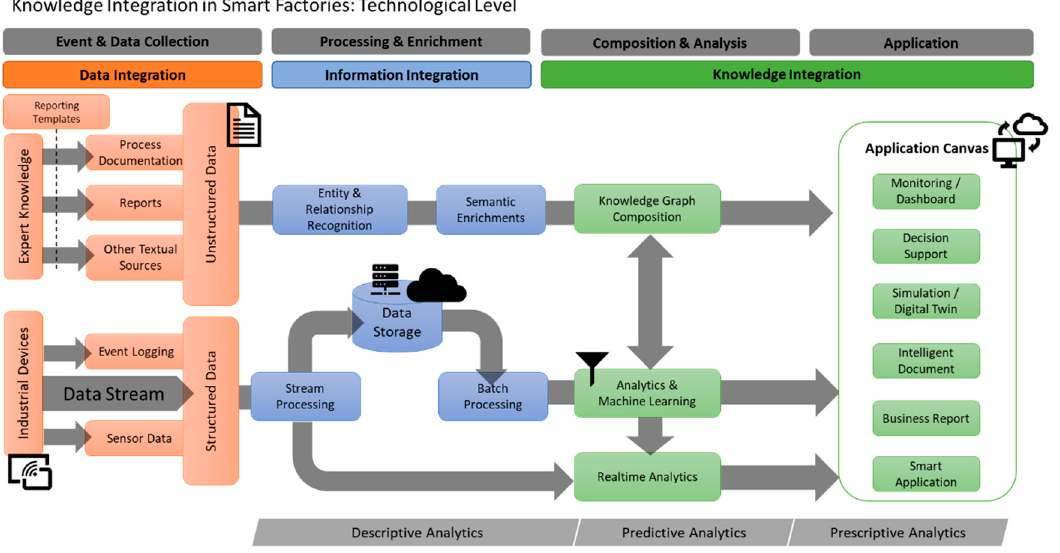
Figure 2. Smart Factory Environment—Technological Level.